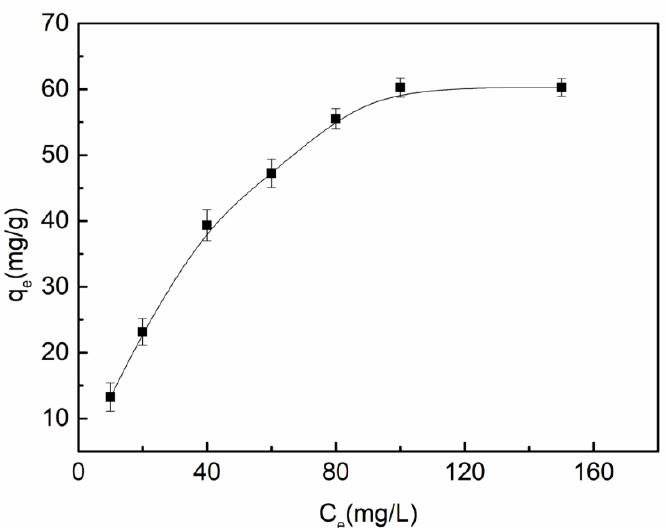
Figure 11. Relation curve between adsorption equilibrium concentration and adsorption capacity of 5 wt% CTS-MMT composite fiber membrane when pH value of Cu 2+ adsorption solution (100 mg/L) is 5.